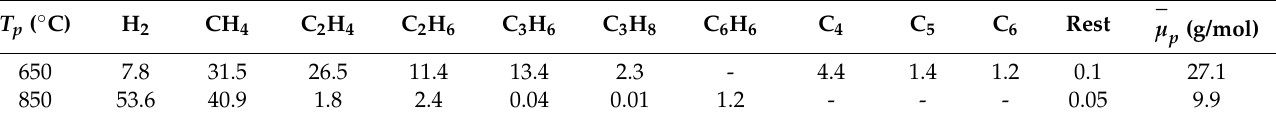
Table 3. Pyrogas composition (%(vol.)) during pyrolysis of granular PE in a closed GG at m 0 = 1 g. T p ( ◦ C)